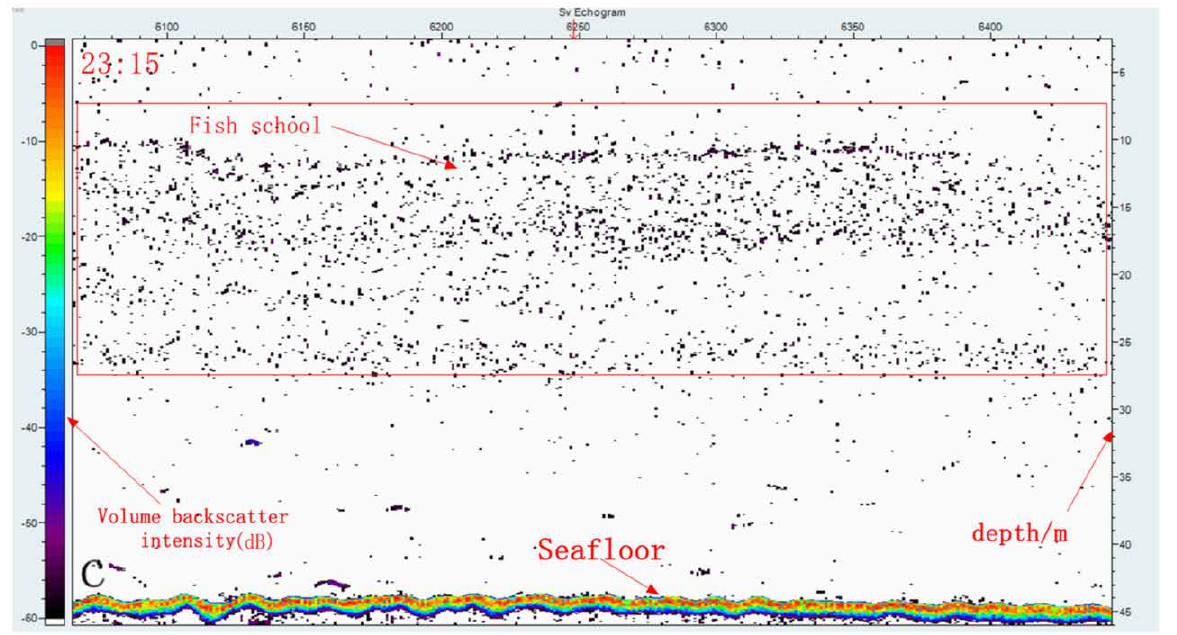
Figure 6. ( a ) The vertical distribution of fish density and acoustic biomass in study area. The red, bule, green and yellow lines represent fish density (night), acoustic biomass (night), fish density (day) and acoustic biomass (day) respectively; ( b ) acoustic mapping of fish school at 11:35 a.m.; ( c ) acoustic mapping of fish school at 11:15 p.m.